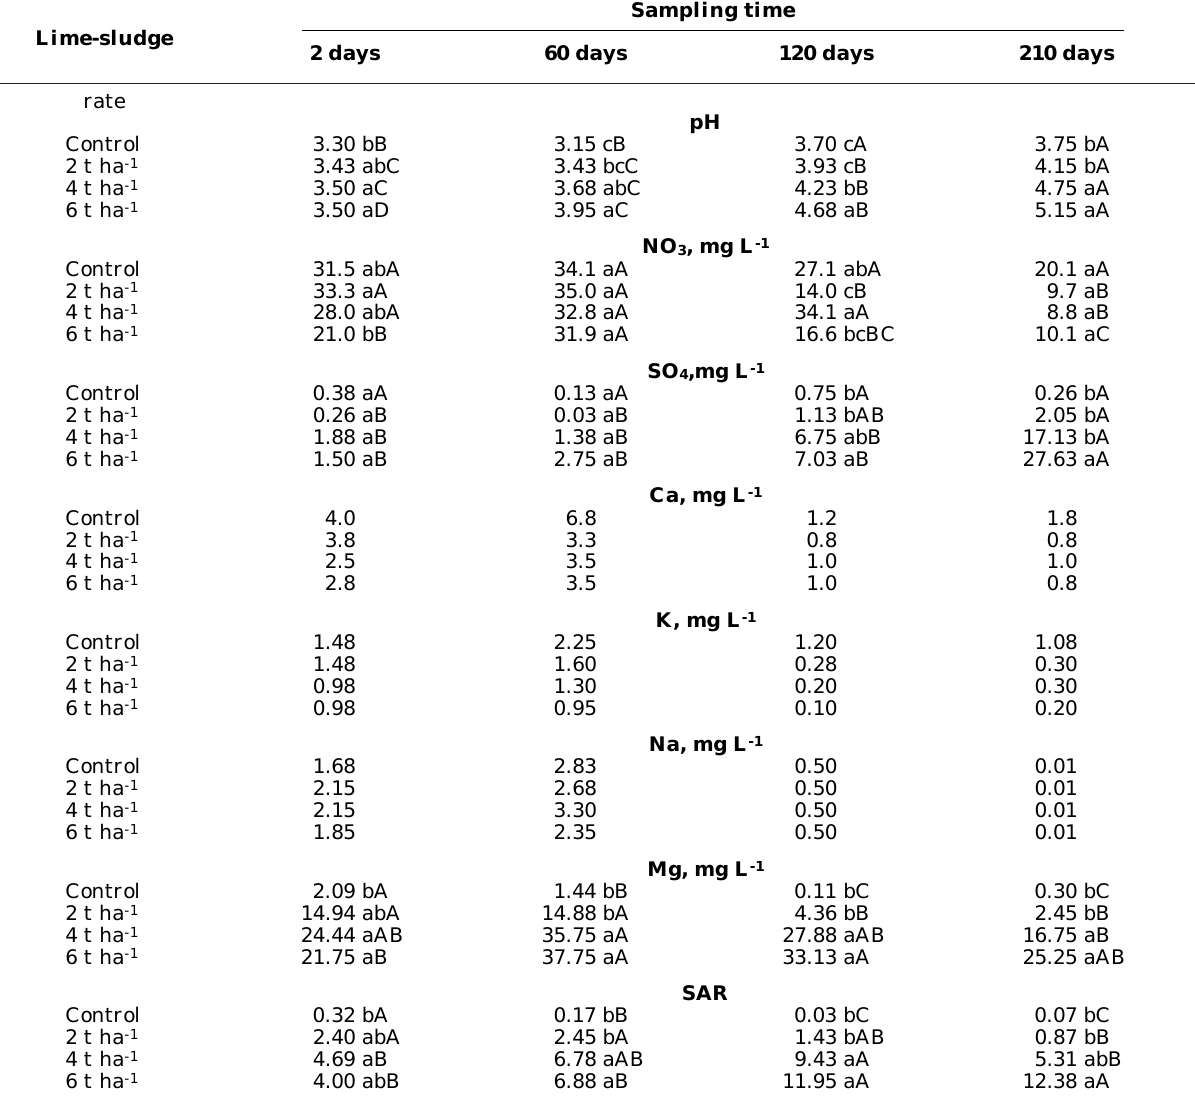
Table 3. Effect of lime-sludge rates and sampling times on soil leachate composition